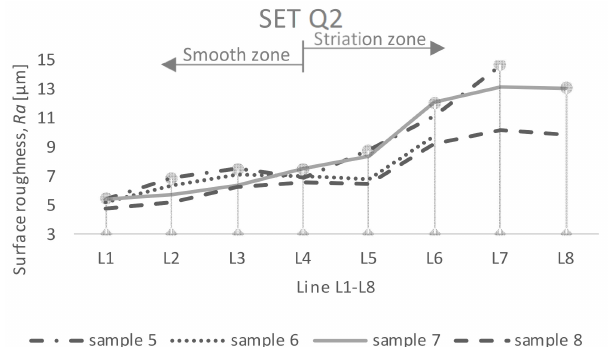
Figure 6. Evaluation of surface topography created by the AWJ (set Q2).